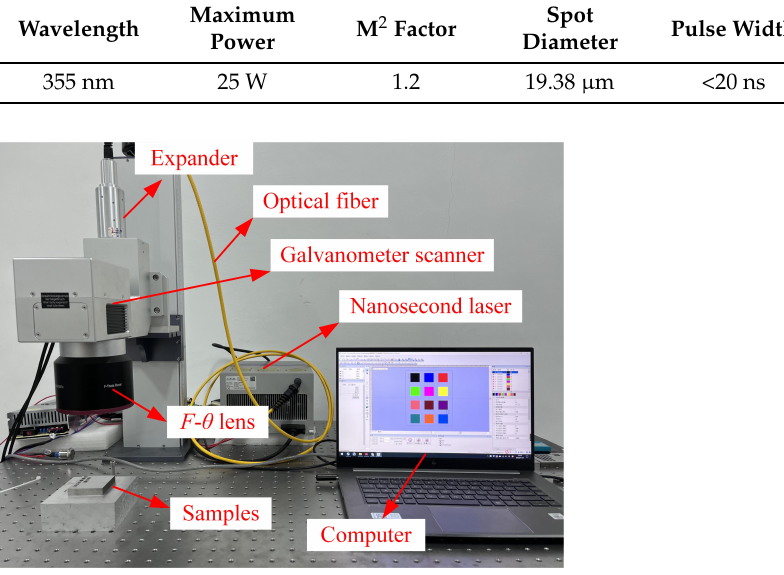
Figure 1. The experimental